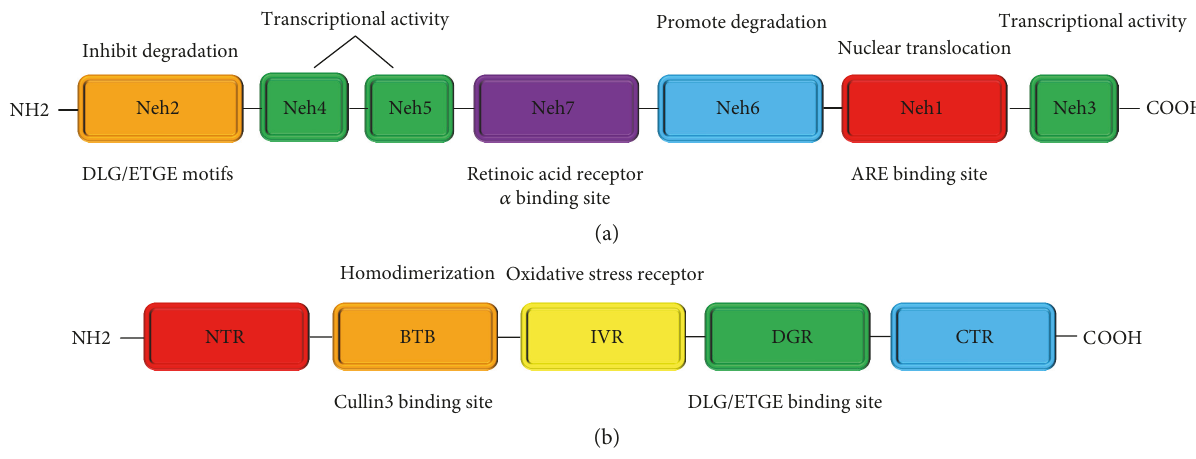
Figure 1: Molecular structure of Nrf2 (a) and Keap1 (b) proteins. (a) There are seven domains in the Nrf2 molecule, and a brief explanatory note for the main function of each domain was given. (b) There are fi ve domains in the Keap1 molecule, and a brief explanatory note for the main function of each domain was